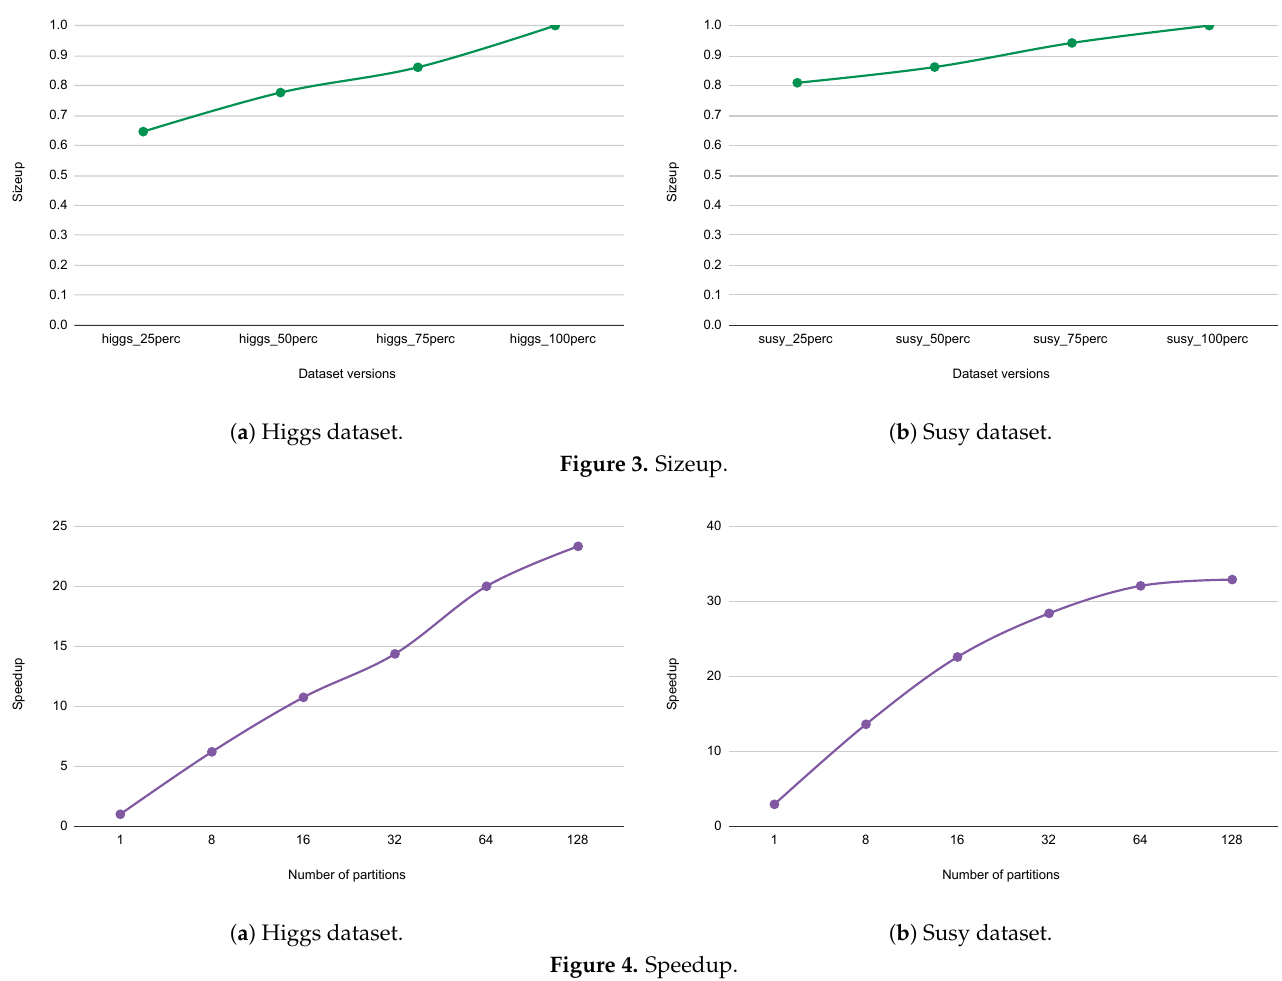
Figure 3. Sizeup.